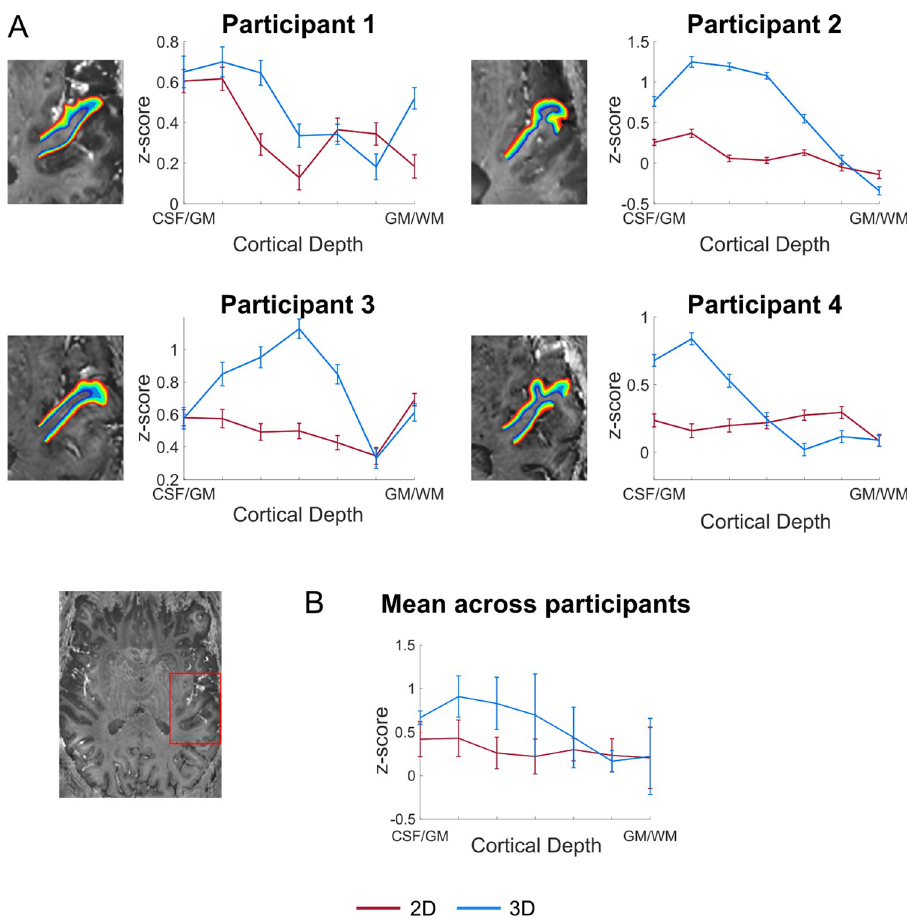
Fig 3. Z-scored cortical depth-dependent activation changes for the 2D- and 3D-EPI VASO data. (A) The anatomically-informed ROI was drawn on the bias field corrected mean 3D-EPI VASO (example at the left bottom). The fMRI layer-dependent changes across depths for each participant. (B) Average z-scored layer-dependent activation changes across participants.